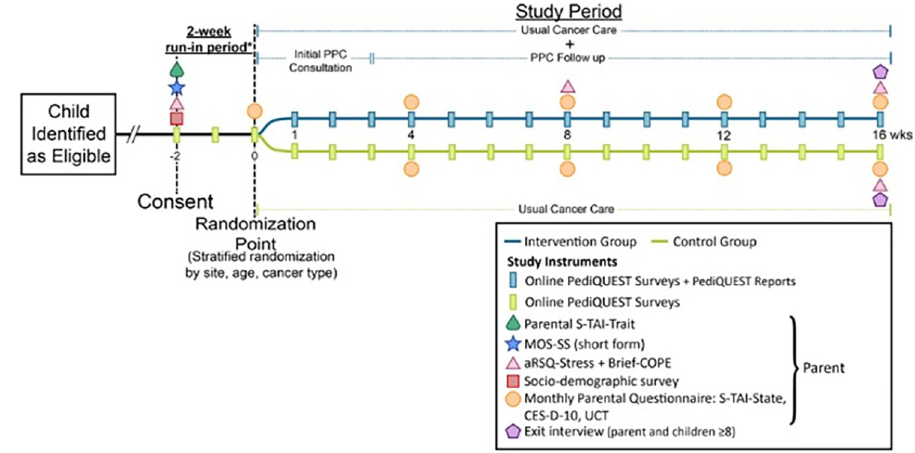
Fig 1. PediQUEST response trial overview. � After consent there is a two-week run-in period to identify (and exclude) non-responders (i.e., dyads who answer < 2 PQ-Surveys/participant). Abbreviations : S-TAI: Spielberger’s State-Trait Anxiety Inventory (two components: State and trait); MOS-SS: Medical Outcomes Study-Social Support; CES-D-10: Center for epidemiologic Studies Short Depression Scale; UCT: Use of Complementary Therapies Checklist; aRSQ-Stress: Adapted Response to Stress Questionnaire (stress